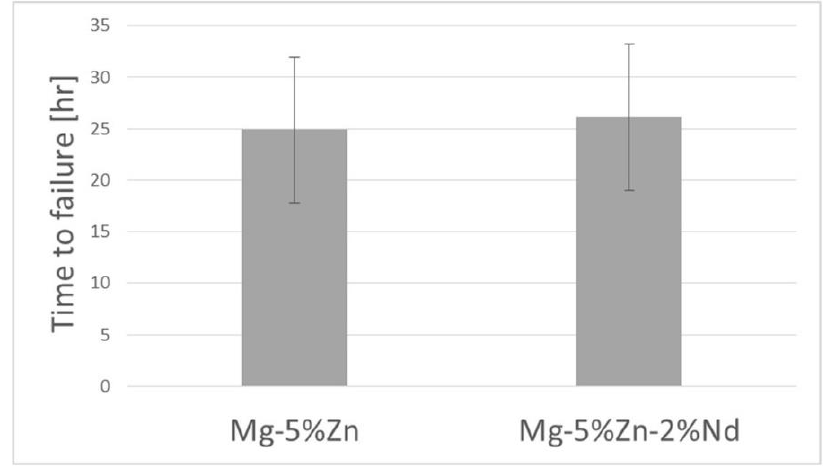
Figure 12. Time to failure of Mg-5%Zn and Mg-5%Zn-2%Nd in PBS solution at a strain rate of 2.5 × 10 −7 s −1 .